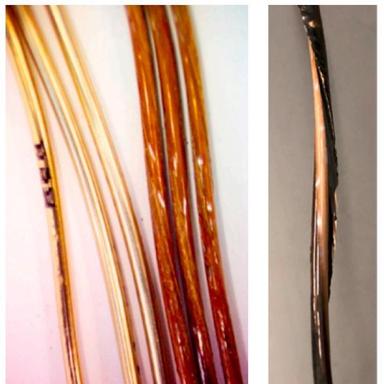
Baseline (left), atmospheric (middle), and vacuum (right) PEEK insulations.